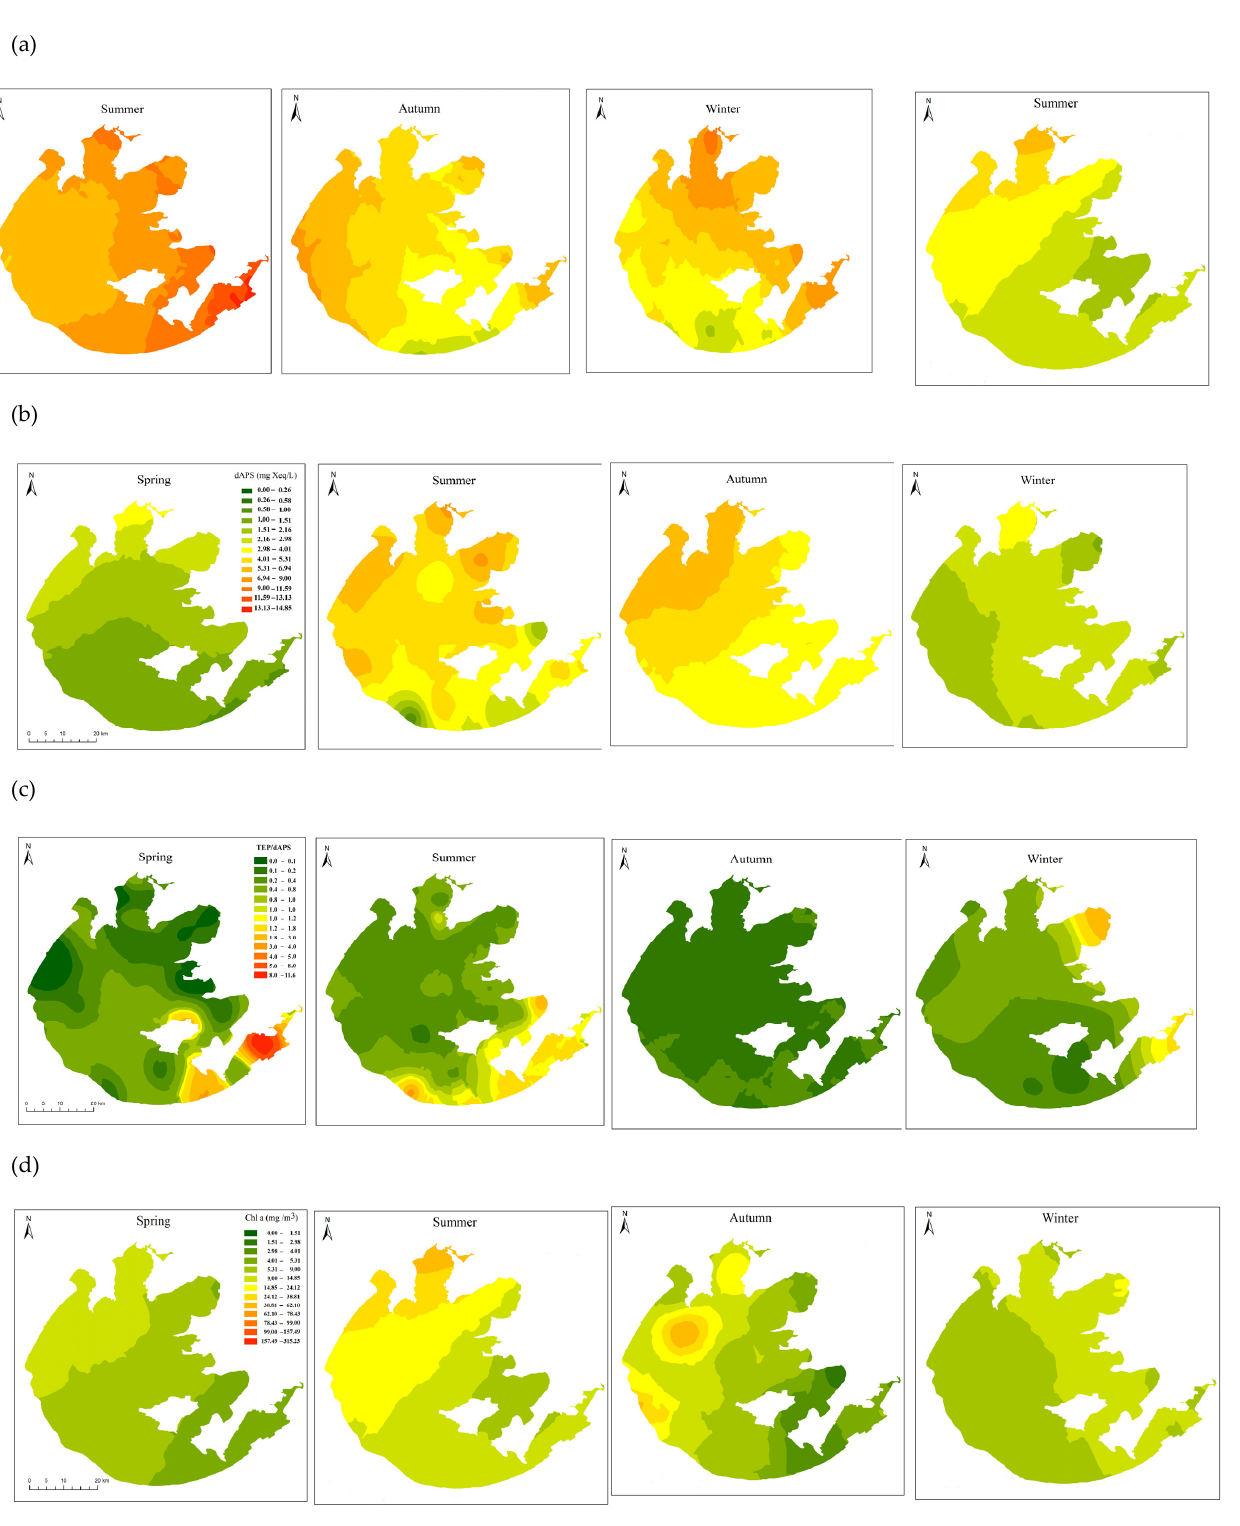
Figure 2. Spatial distribution of transparent exopolymer particles (TEP) ( a ), dissolved acidic polysac- charides (dAPS) ( b ), TEP/dAPS ratio ( c ), chlorophyll a (Chl a) ( d ) concentrations during four seasons in Lake